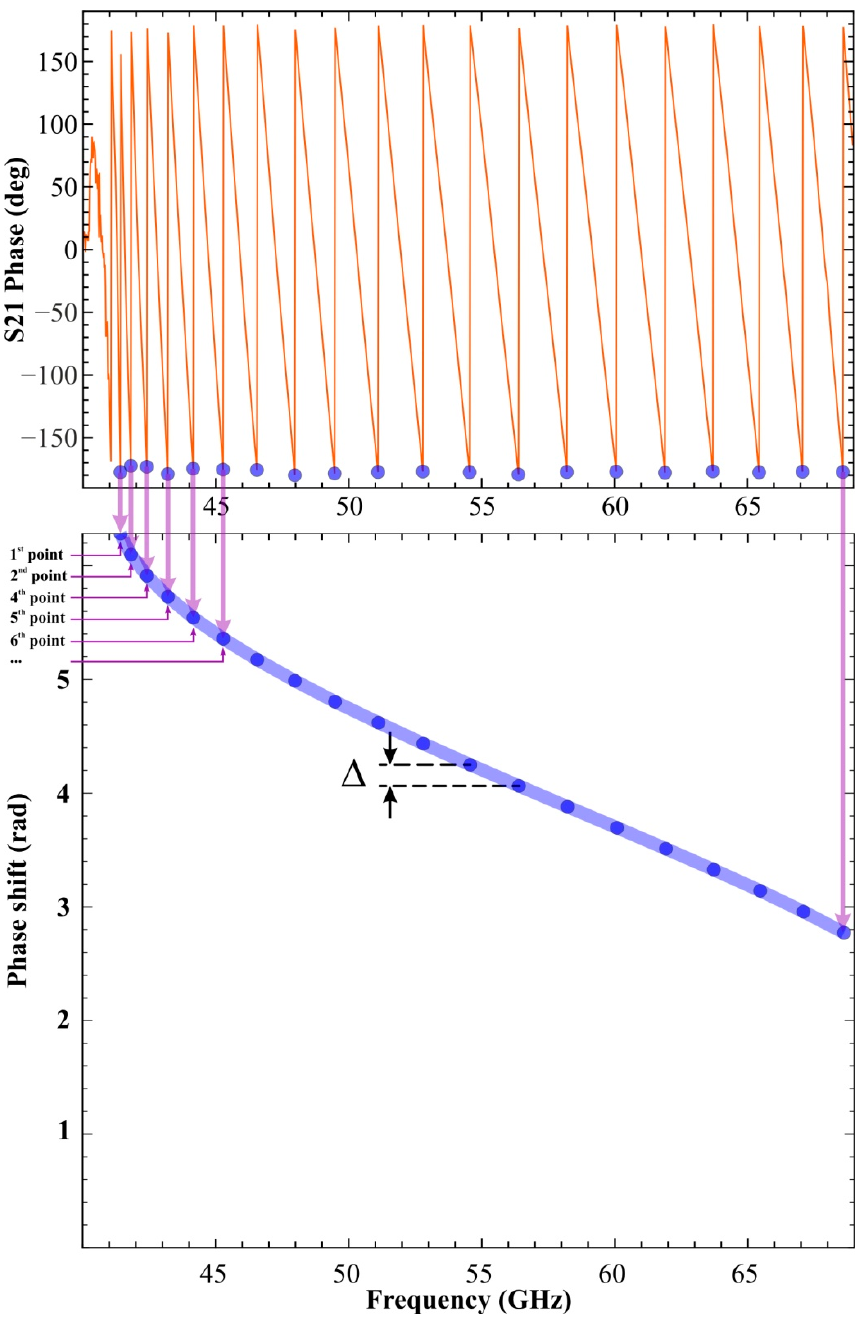
Figure 8. Illustration of the reconstruction of the dispersion characteristic from the experimentally measured phase data.